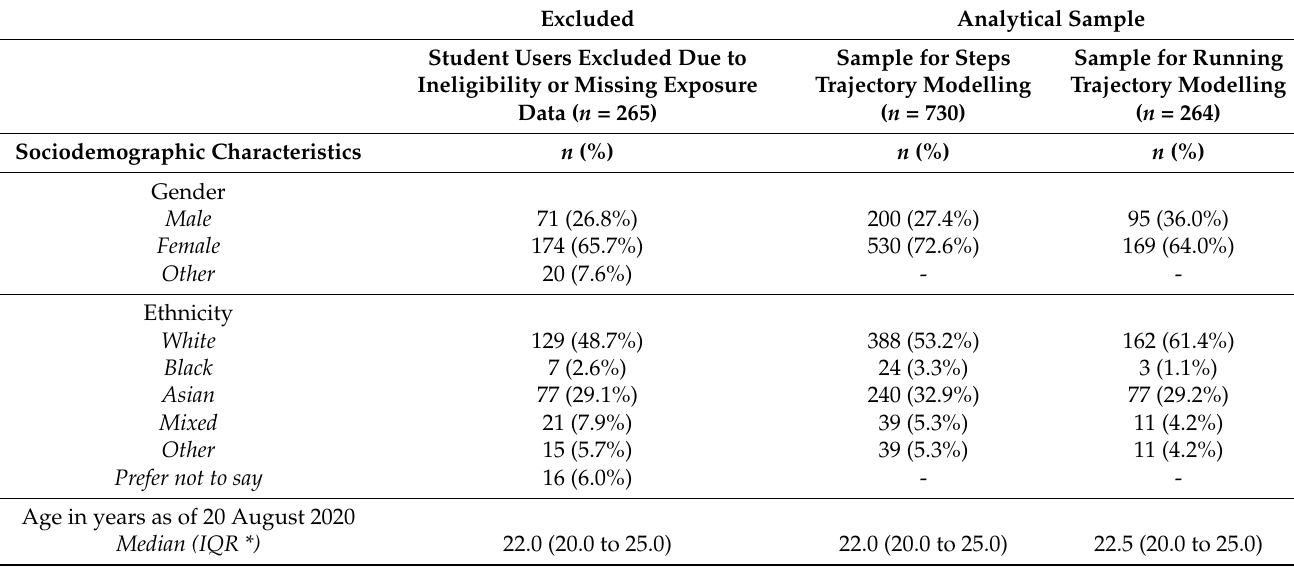
Table 1. Sociodemographic characteristics of student users excluded or included in analyses.